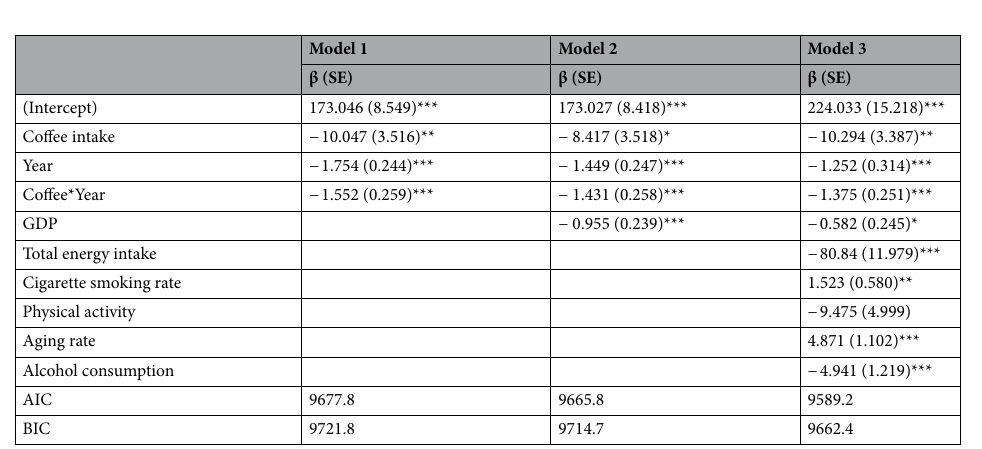
Figure 1. Changes in coffee intake ( A ) and mortality ( B ) and incidence ( C ) rates of ischeemic heart disease (IHD) from 1990 to 2018 globally and for GBD Super Regions.